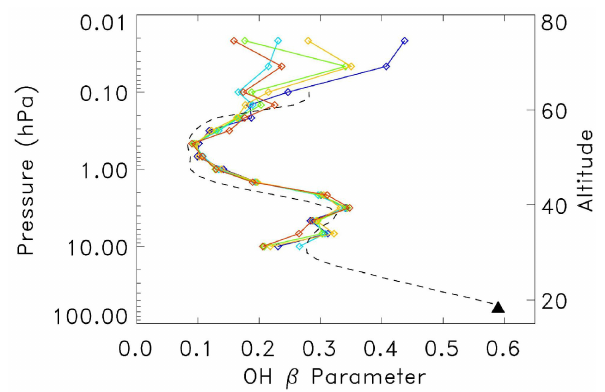
Fig. 4. Vertical profiles of the OH-SZA fit parameter β from MLS measurements during the NH summer of 2004 (blue), 2005 (cyan), 2006 (green), 2007 (orange), and 2008 (red). Dashed curve shows the corresponding β from simulations of the SLIMCAT model for 2005. Solid triangle indicates β value derived from a fit to the air- craft OH measurements by Hanisco et al. (2001).